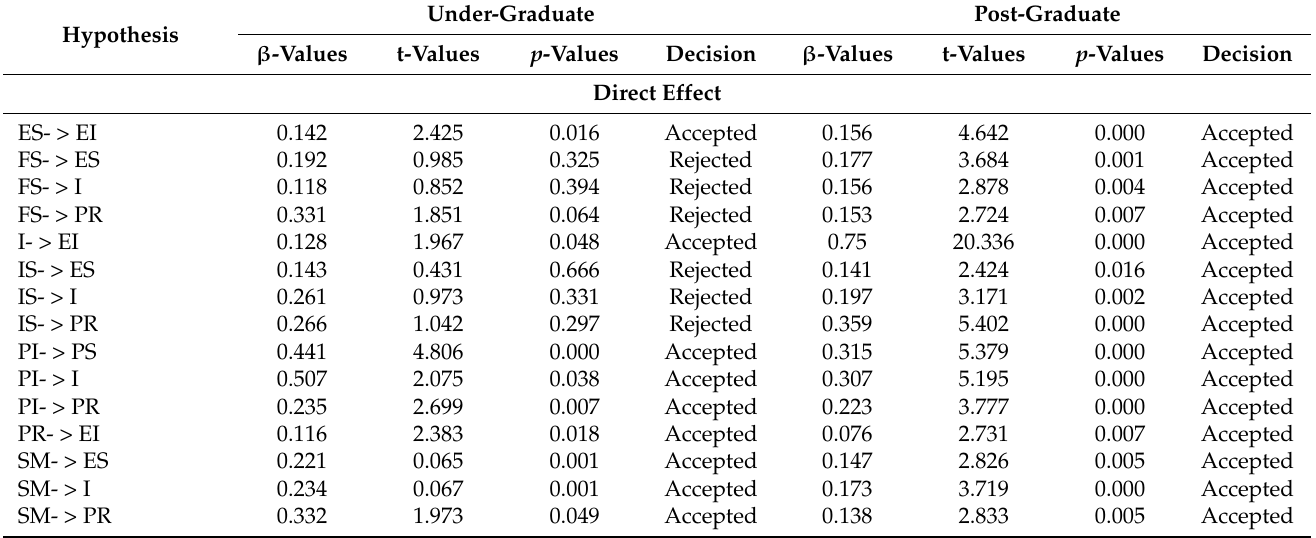
Table 8. Comparative analysis for